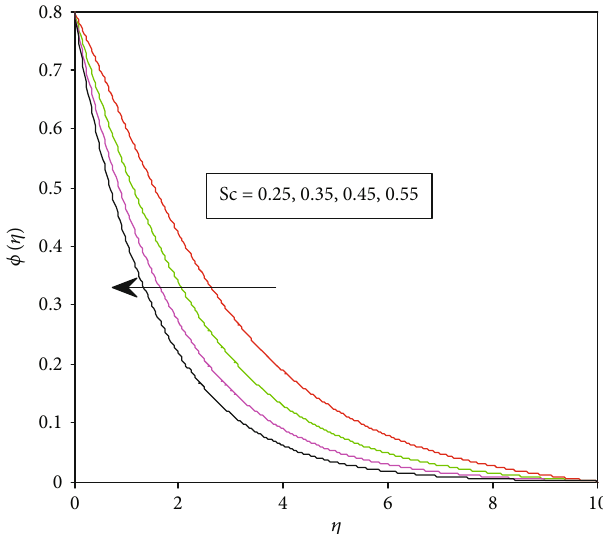
Figure 26: Concentration distribution for di ff erent values of the Schmidt number.